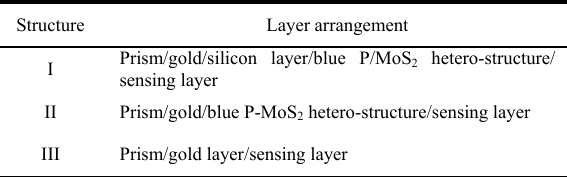
Table 1 Schematic structure of the SPR sensor.